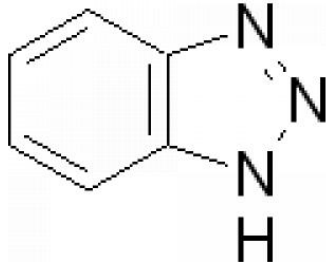
Figure 15. The chemical structure of BTA.